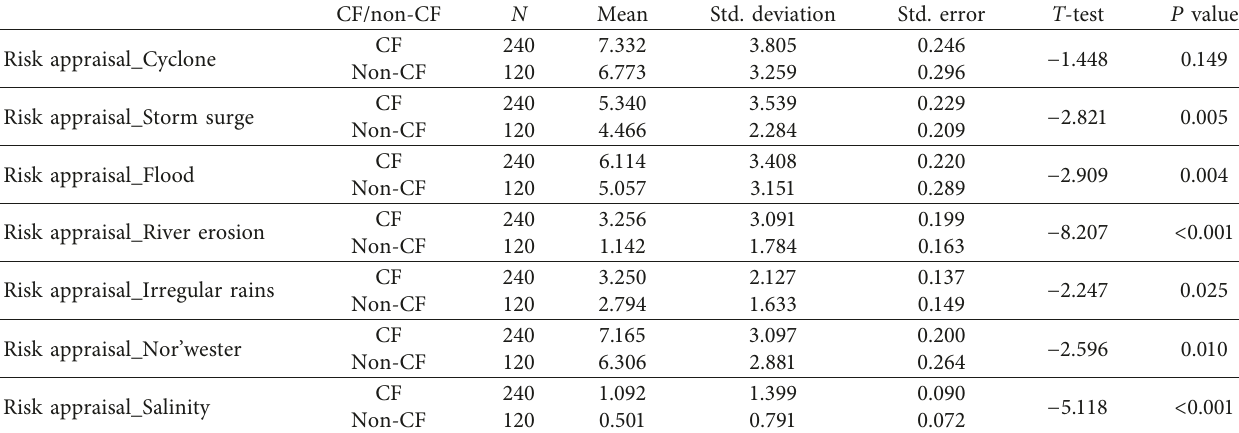
Table 7: Mean, standard deviation, and standard error of the risk appraisal of the households. N Std.